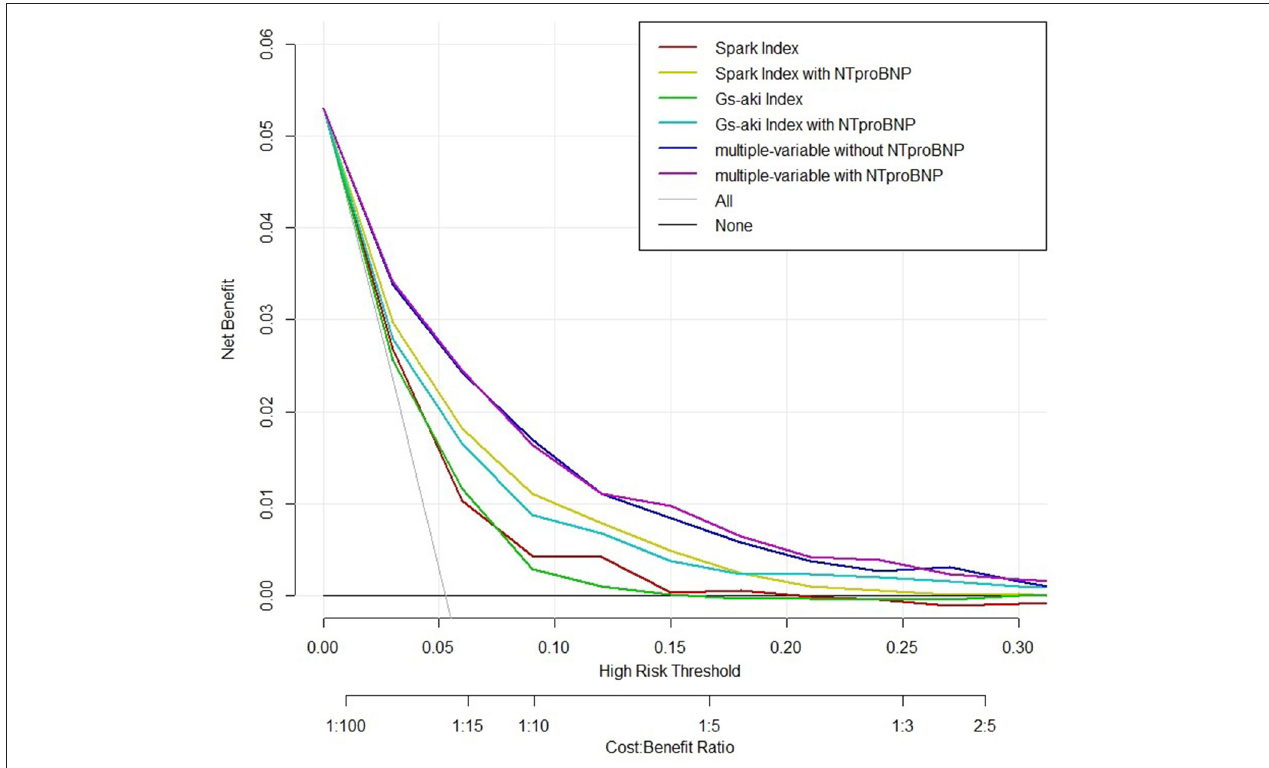
FIGURE 3 | Decision curve analysis. Decision curve was developed for evaluating the net benefit of using models with or without pre-operative NT-proBNP for preventive management decisions for PO-AKI. NT-proBNP, N-terminal pro-B-type natriuretic peptide; GS-AKI index, the weighted general surgery acute kidney injury risk index; SPARK index, Simple Post-operative AKI Risk